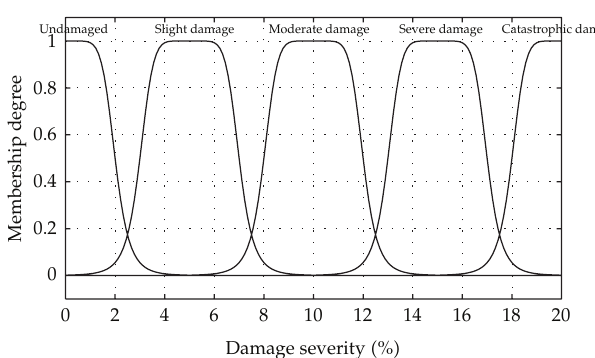
Figure 3: Schematic diagram of membership function for damage severity.